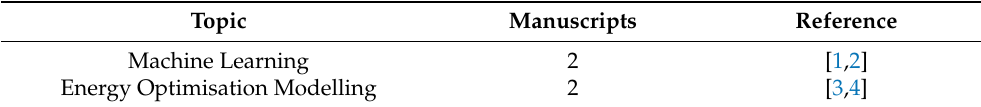
Table 3. Topics of energy efficiency and energy consumption modelling using artificial neural